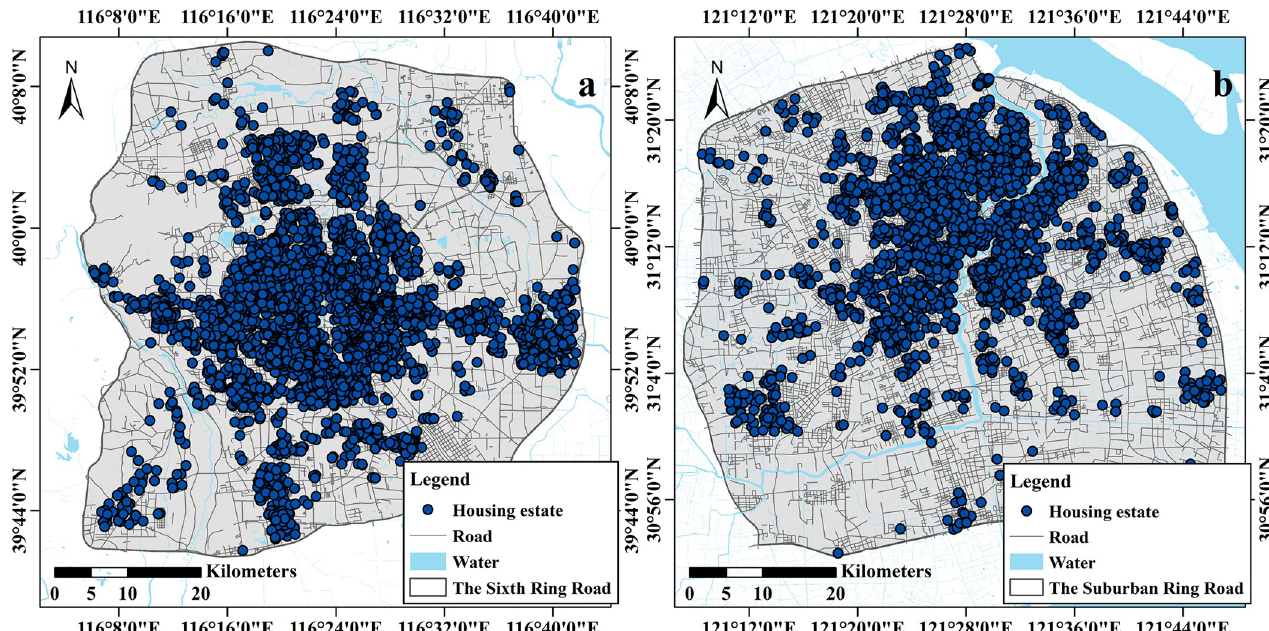
Fig 1. Study areas (the vectorized maps included the zone boundary, simplified road, water and housing plot shapefiles, and the corresponding files can be found at https://doi.org/10.6084/m9.figshare.7823969.v1).